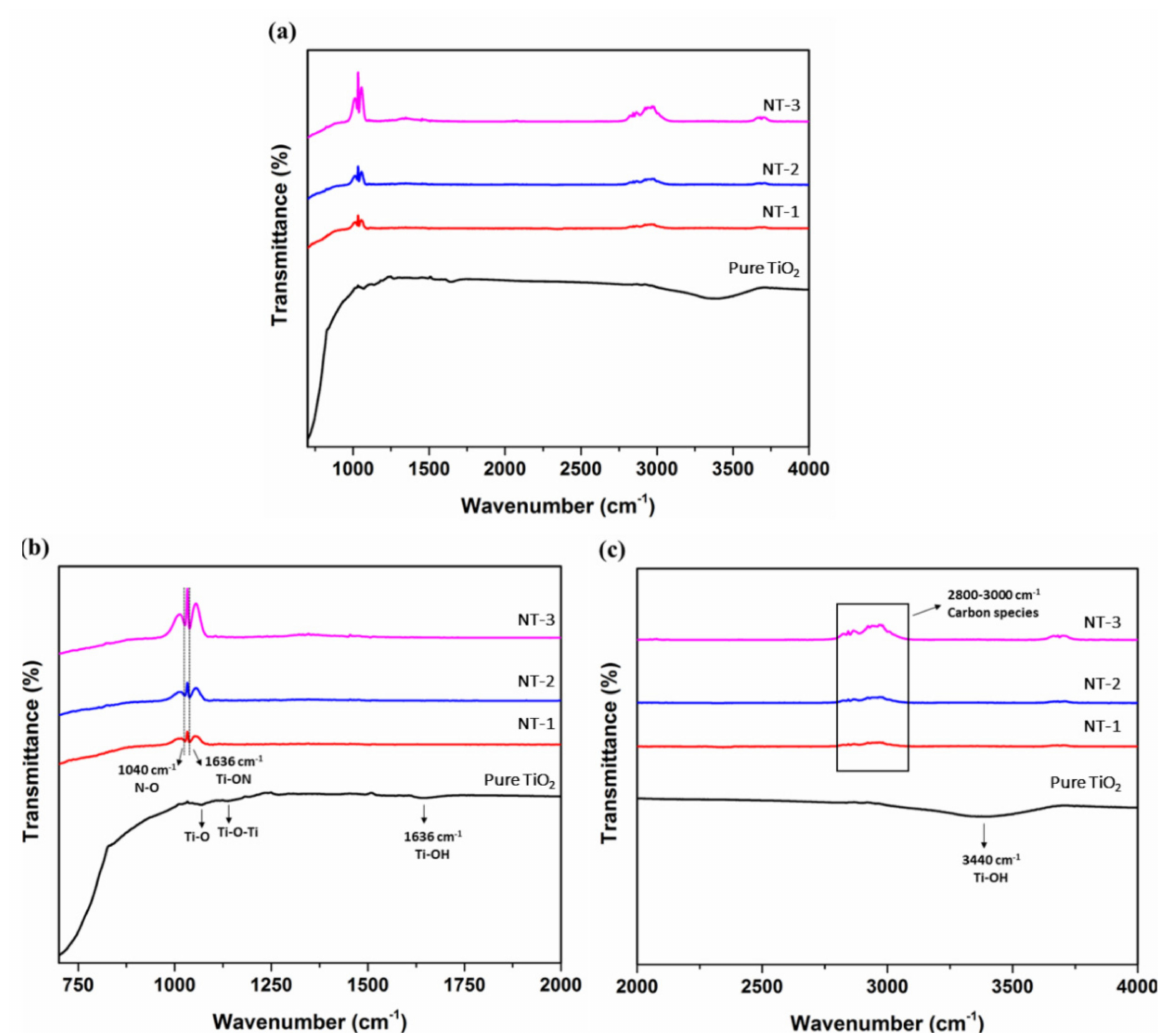
Figure 4. FTIR spectra of pure TiO 2 , NT-1, NT-2 and NT-3, synthesized by using 0.0 g, 0.983 g, 1.965 g and 2.940 g of urea respectively. ( a ) The complete spectrum; The enlarged view of regions between 750–2000 cm − 1 ( b ), and 2000–4000 cm − 1 ( c ).